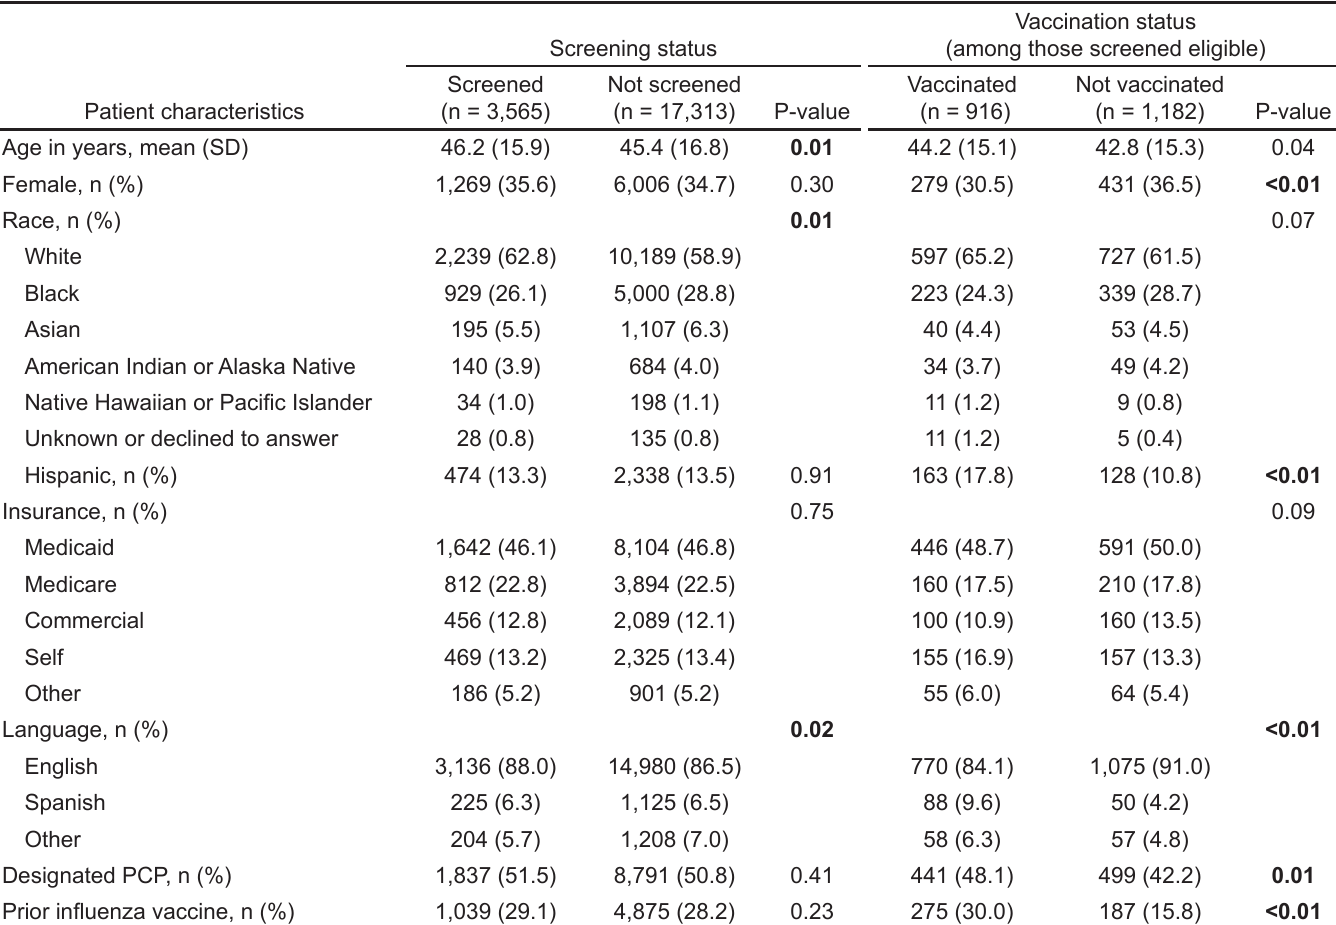
Table 1. Descriptive characteristics of patients and emergency department visits, by screening status and vaccination status.